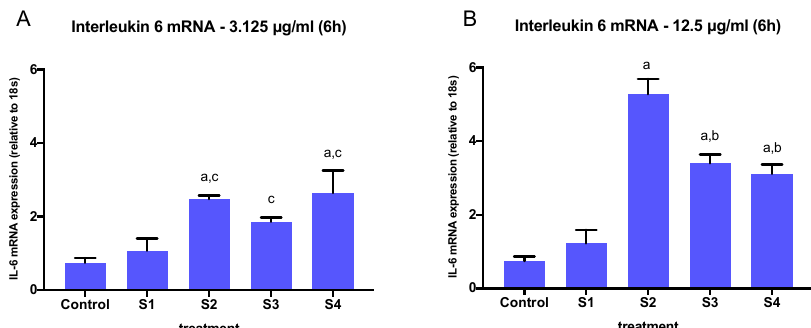
Figure 7. Human IL-6 mRNA (IL6) expression (relative to 18s) in BEAS-2B cells treated with S1–S4 soot at 3.125 μ g/mL ( A ) or 12.5 μ g/mL ( B ) for 6 h. The graphs summarize data from three independent experiments ( n = 3 replicates per experiment), with results normalized to controls (exposed to methanol) and expressed as mean ± SEM. a: different from control and S1 ( p < 0.001), b: different from S2 ( p < 0.05), c: different from control. One-way ANOVA ( p < 0.001, F (3, 8) = 25.7).